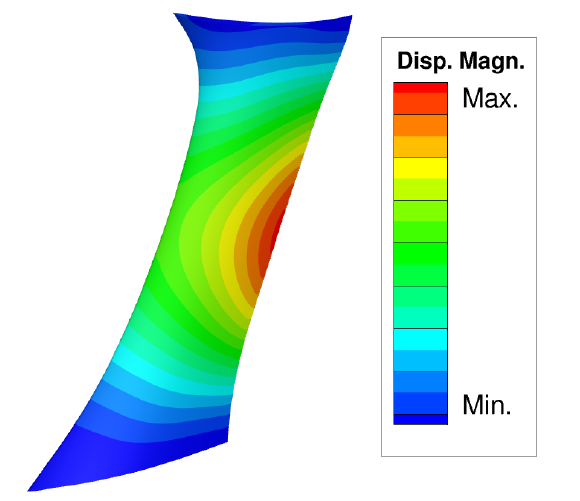
Figure 1. OGV first bow mode.